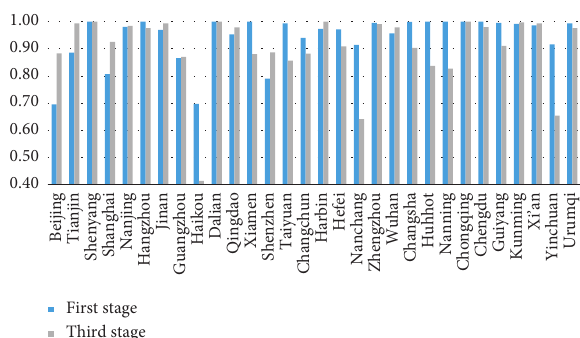
Figure 5: Comparison of average scale efficiency before and after adjustment